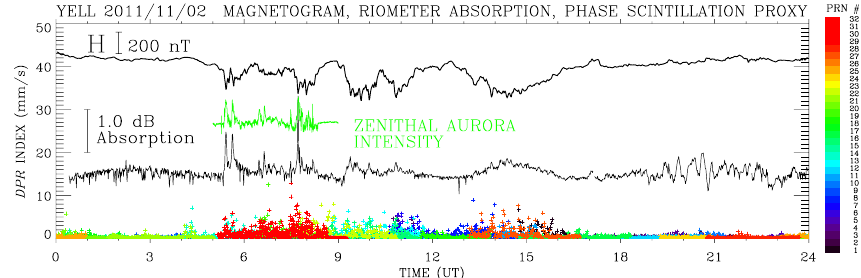
Fig. 9. Phase scintillation proxy index DPR (crosses in colour) for elevations above 30 ◦ , H component of the ground magnetic field and the riometer absorption observed in Yellowknife. Auroral intensity from an approximately 1-km wide pixel in the zenith in relative units is shown in logarithmic scale (green line).